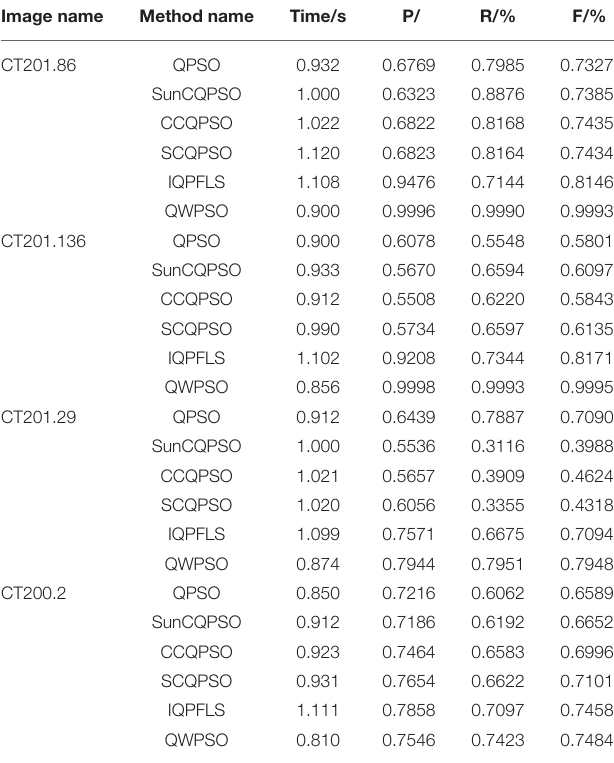
TABLE 4 | Evaluate parameters in test